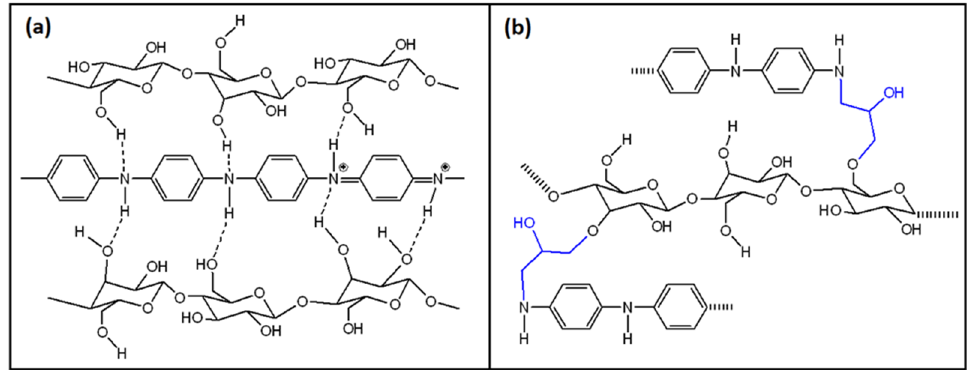
Figure 11. Schematic representation of polymer structures: ( a ) PANI/BC composite; ( b ) PANI/ g EBC composite (cross-linker is highlighted in blue). Based on the results reported in [114,118,119,126]. EBC—epoxy-modified bacterial cellulose.